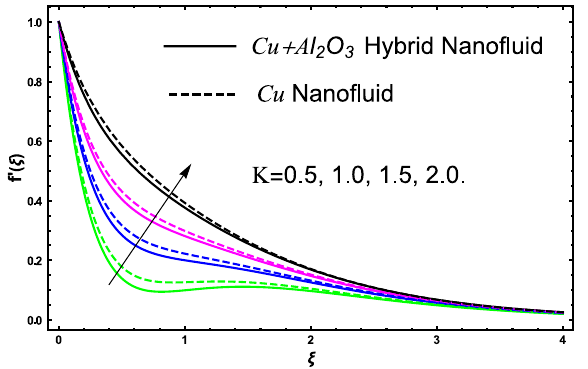
′ (ξ) profile against escalating values of K .